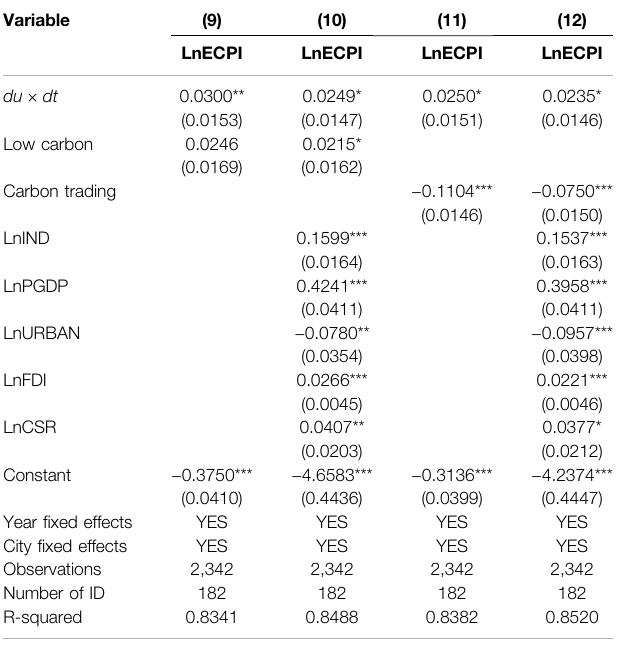
TABLE 5 | Superposition policy